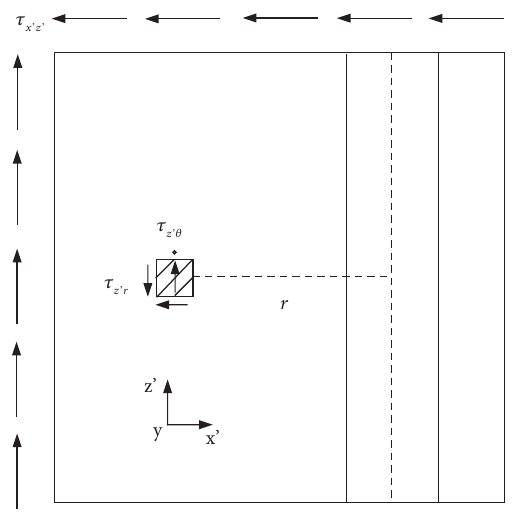
Figure 12: The x ′ - z ′ section view of stress state ( φ � 0 °